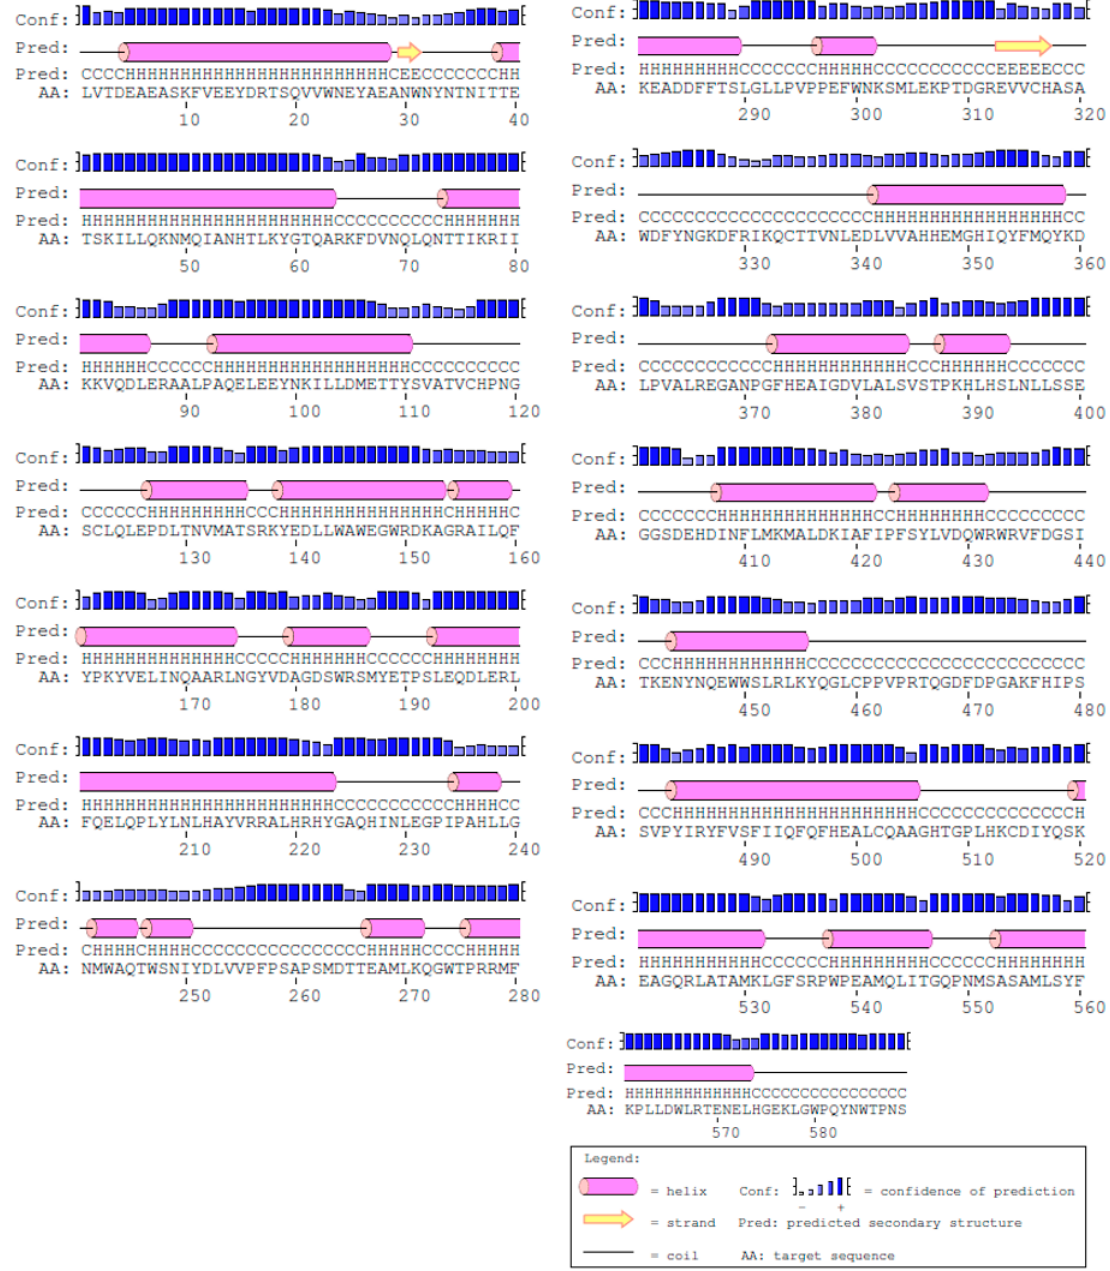
Figure 2. Secondary structure of human ACE; pink cylinders, yellow arrows, and black lines show helixes, strands, and coils, respectively.